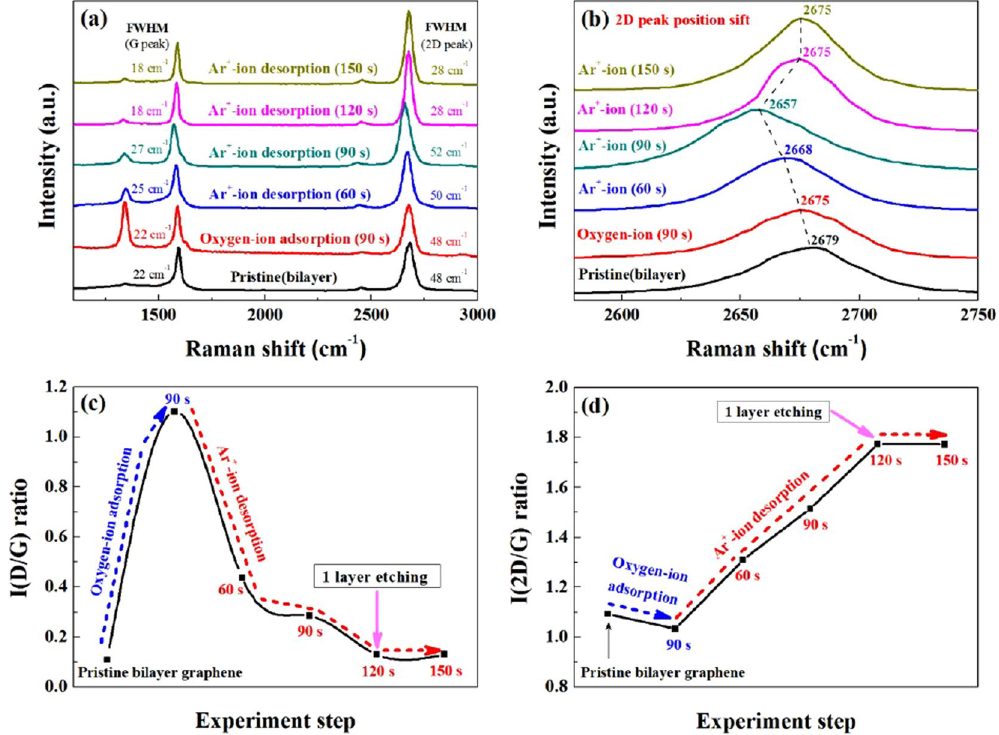
Figure 5. Raman spectroscopic data of bilayer graphene after each step in one cycle of graphene ALE. ( a ) Raman spectra of bilayer graphene after each step in one cycle of graphene ALE. Different time of Ar + -ion desorption was conducted after the chemical adsorption of the oxygen (O 2 + /O + )-ion for 90 s. ( b ) The shift of 2D peak of Raman spectra after oxygen-ion adsorption and after the following Ar + -ion desorption for different time. ( c and d ) are the change of the peak intensity ratio of D/G and 2D/G of the bilayer graphene Raman spectra in ( a ),